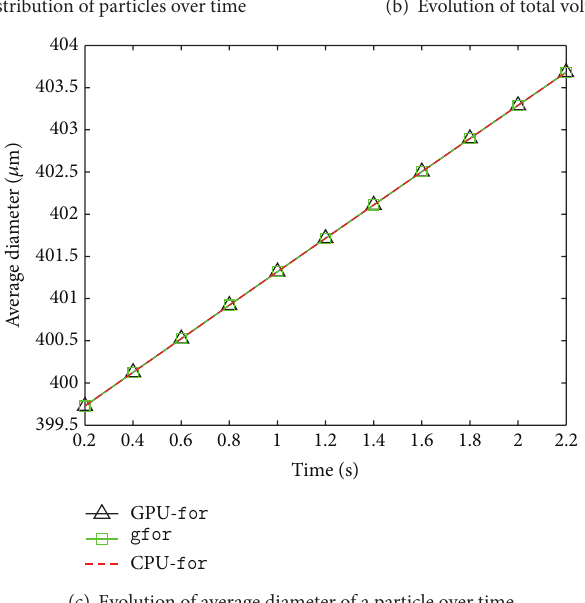
Figure 1: Comparison of temporal evolution of granule physical properties simulated using gfor , GPU- for , and CPU- for . which will lend itself better to parallelization in conjunction with constructs like gfor